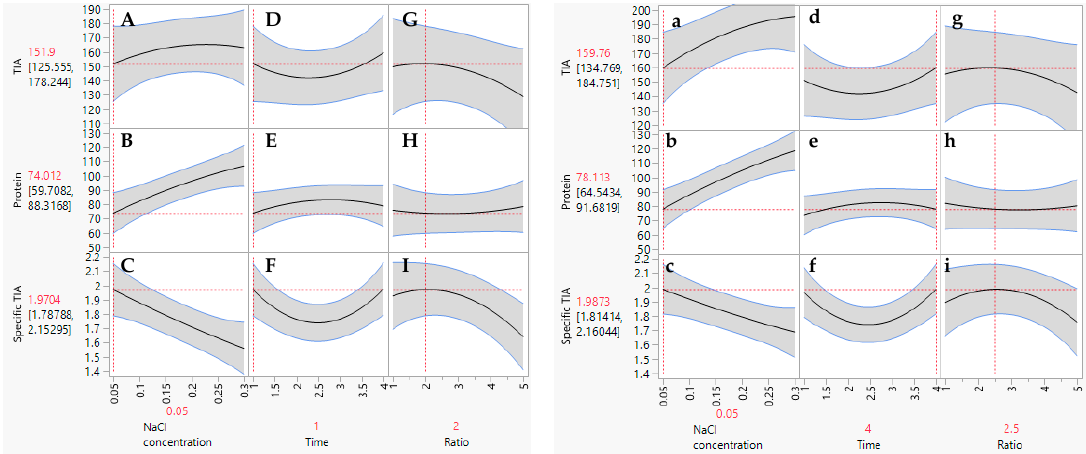
Figure 2. Prediction profiler plots for TIA, protein and specific TIA relative to NaCl concentration, time, and ratio of defatted powder to solvent. Two sets of optimal conditions were predicted as per the panels on the left (capital letters) and the panels on the right (small letters).